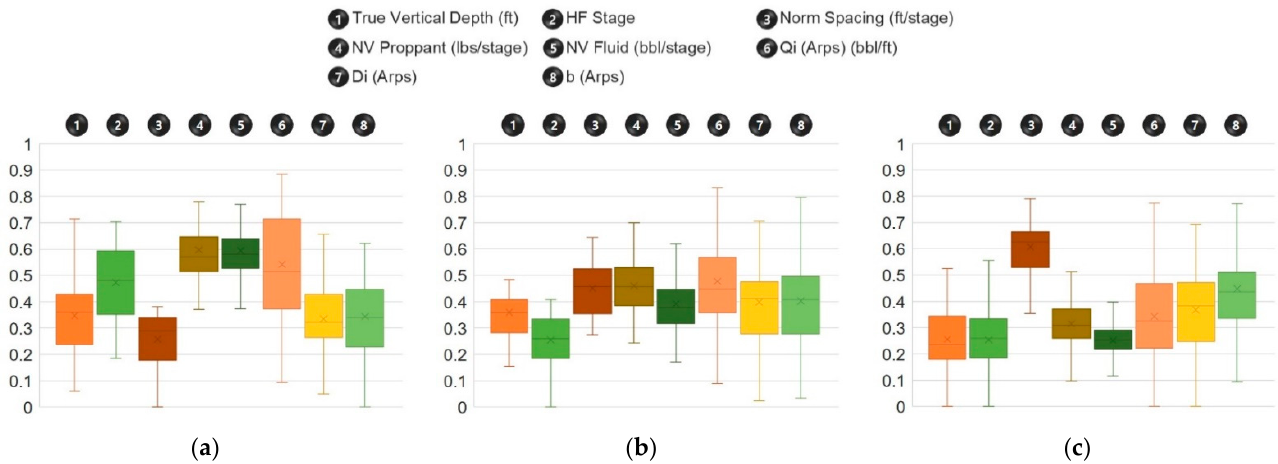
Figure 17. Normalized variable distribution of key and production factors by group: ( a ) Cluster 1; ( b ) Cluster 2; ( c ) Cluster 3.